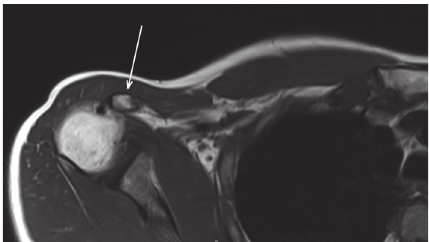
Figure 1: MRI axial T1 showing full-thickness PM tear at the humeral tendon-bone junction.